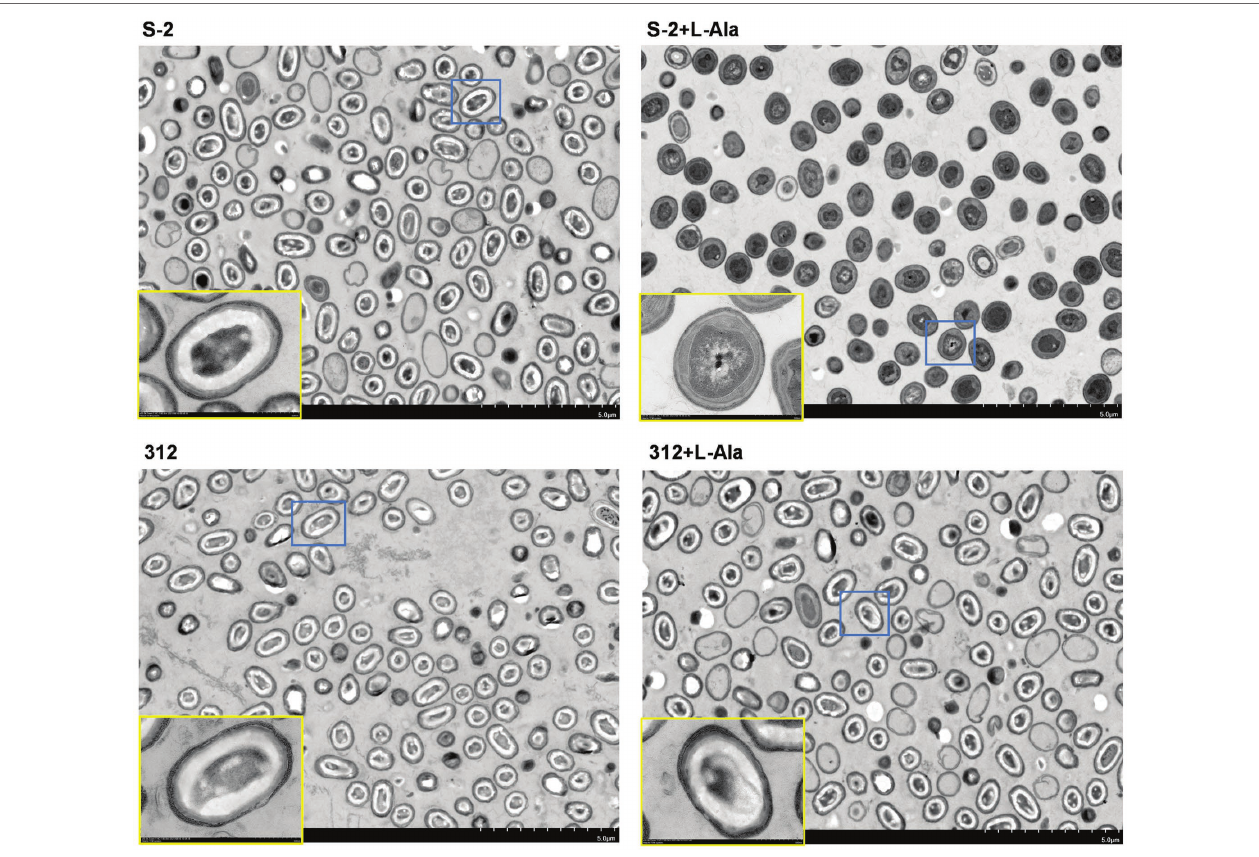
FIGURE 3 | Morphological changes of B. subtilis S-2 and 312 with L-alanine treatment. The cell morphology of B. subtilis S-2 spores, L-alanine treated B. subtilis S-2 spores, B. subtilis 312 spores, L-alanine treated B. subtilis 312 spores were displayed by transmission electron microscopy (TEM). The yellow frame is an enlarged version of the blue